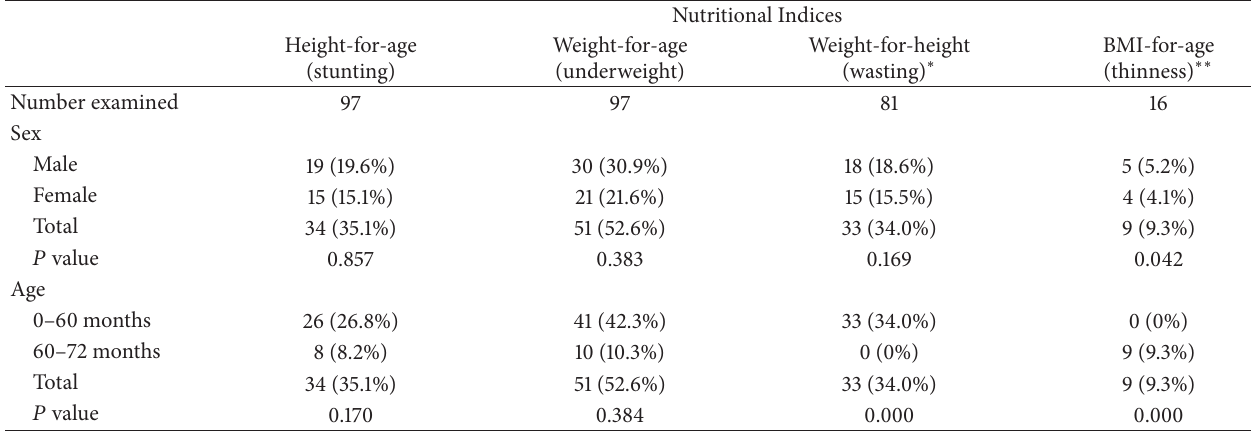
Table 6: Nutritional indices ( 𝑍 -score) of the surveyed preschool aged children by sex and age category.